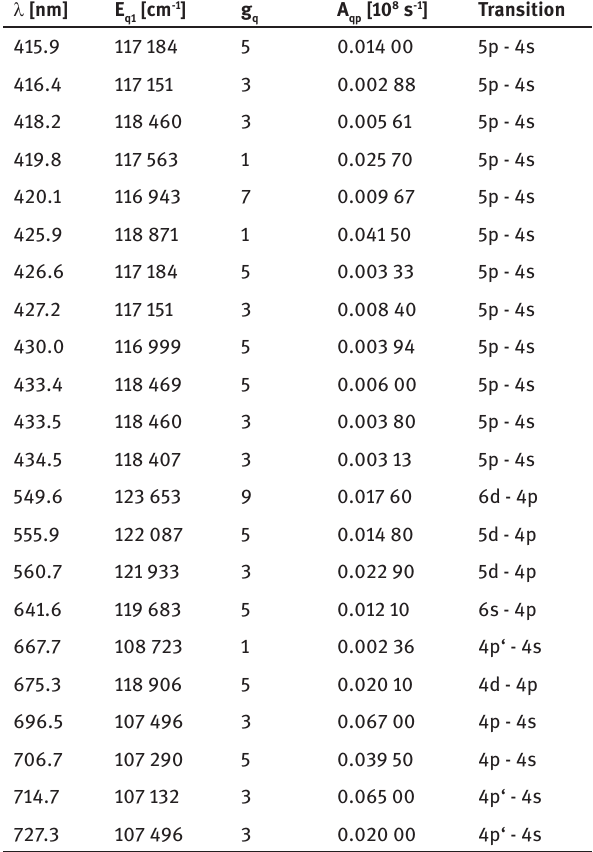
Table 1 : List and characteristics of the argon spectral lines used in determining the excitation temperature through a Boltzmann